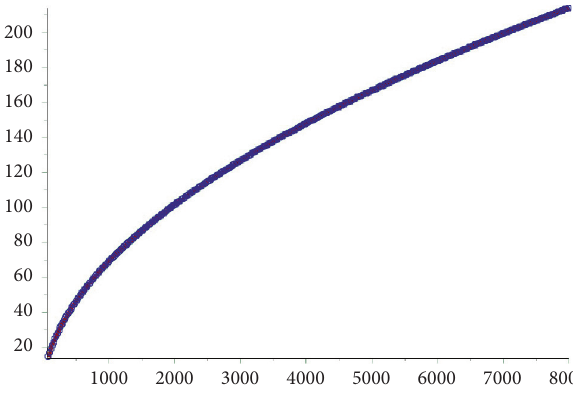
Figure 18: The graph of the data ( n, ln ( h ( n ))) and the fitting